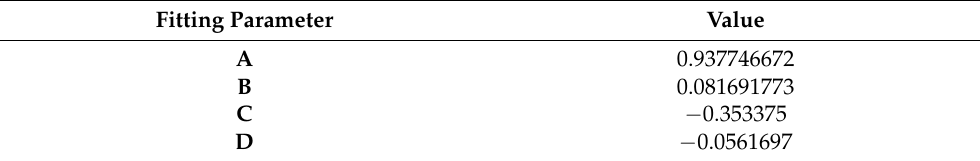
Figure 8. Fitting angle–amplitude (T PS ) data of CTP 88 in the oil reservoir. Table 8. Subsurface parameter values and absolute errors for CTP 88 in the oil reservoir. Table 7. Values of fitting parameters for CTP 88 in the oil reservoir.